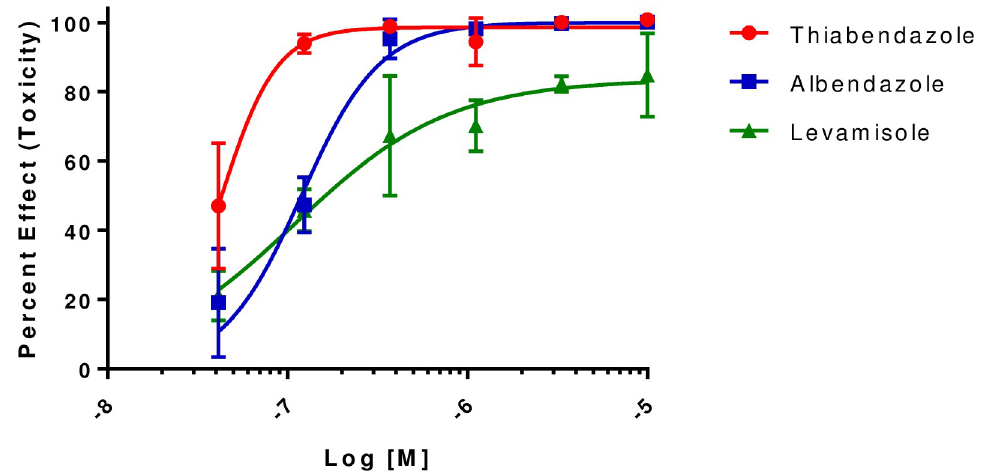
Fig 5. Half-maximal inhibitory concentration (IC 50 ) values of known anthelmintics in the chitinase egg hatching assay. The IC 50 values for Thiabendazole, Albendazole and Levamisole were 43 nM, 119 nM and 109 nM, respectively. Data from replicate experiments performed on two different days is plotted.